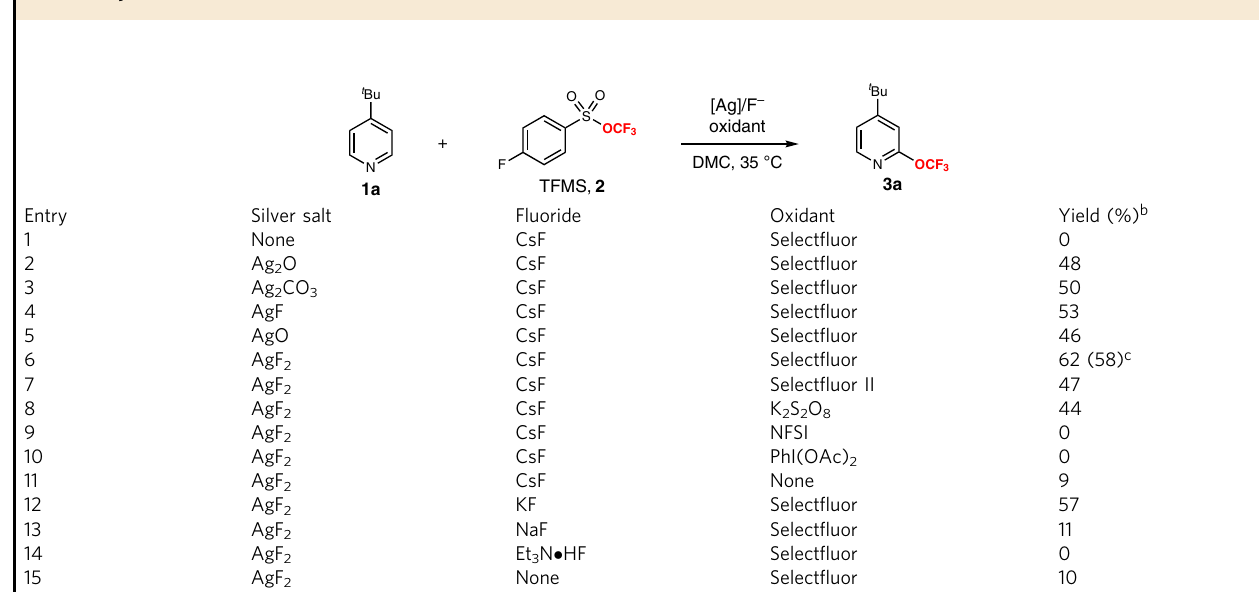
Table 1 Optimization of reaction conditions a